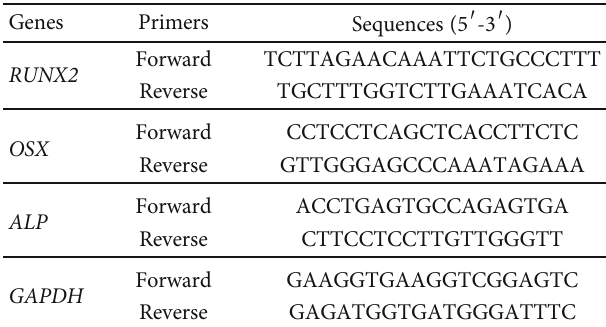
Table 1: Sense and antisense primers for real-time reverse transcription polymerase.